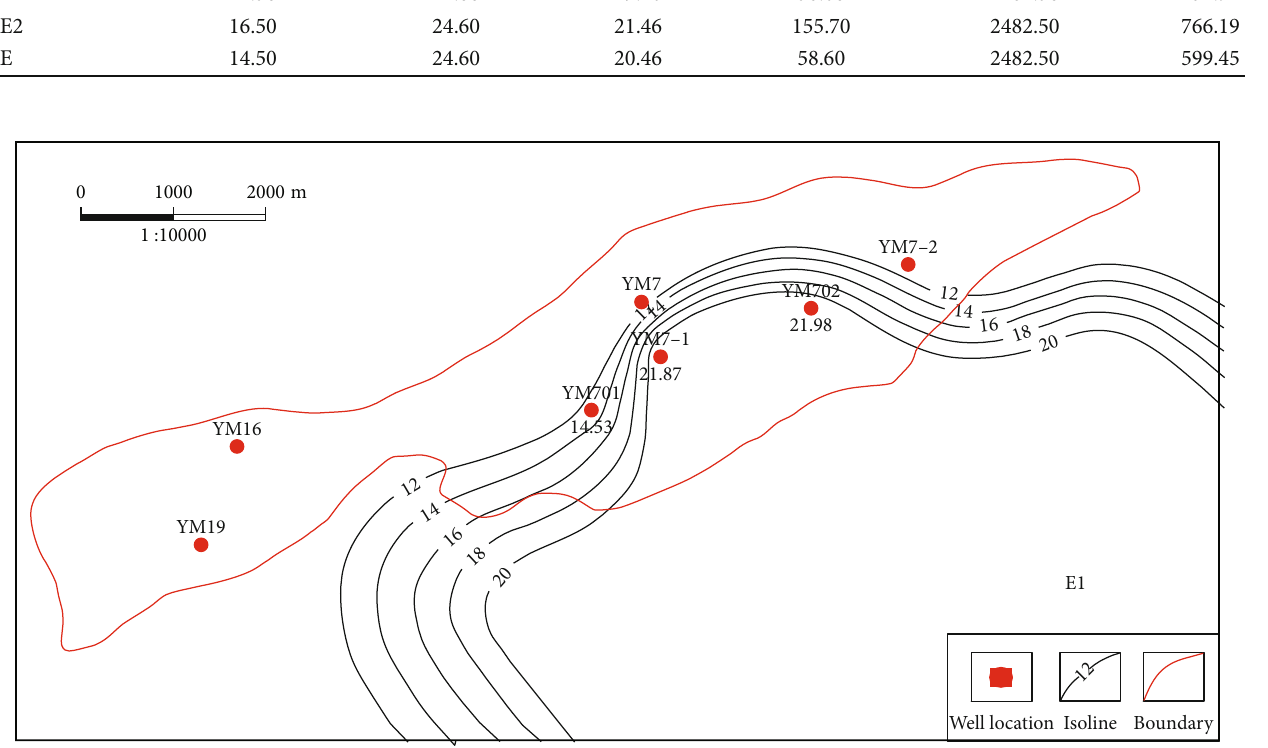
Figure 12: Contour map of porosity in the E1 layer of block Yingmai